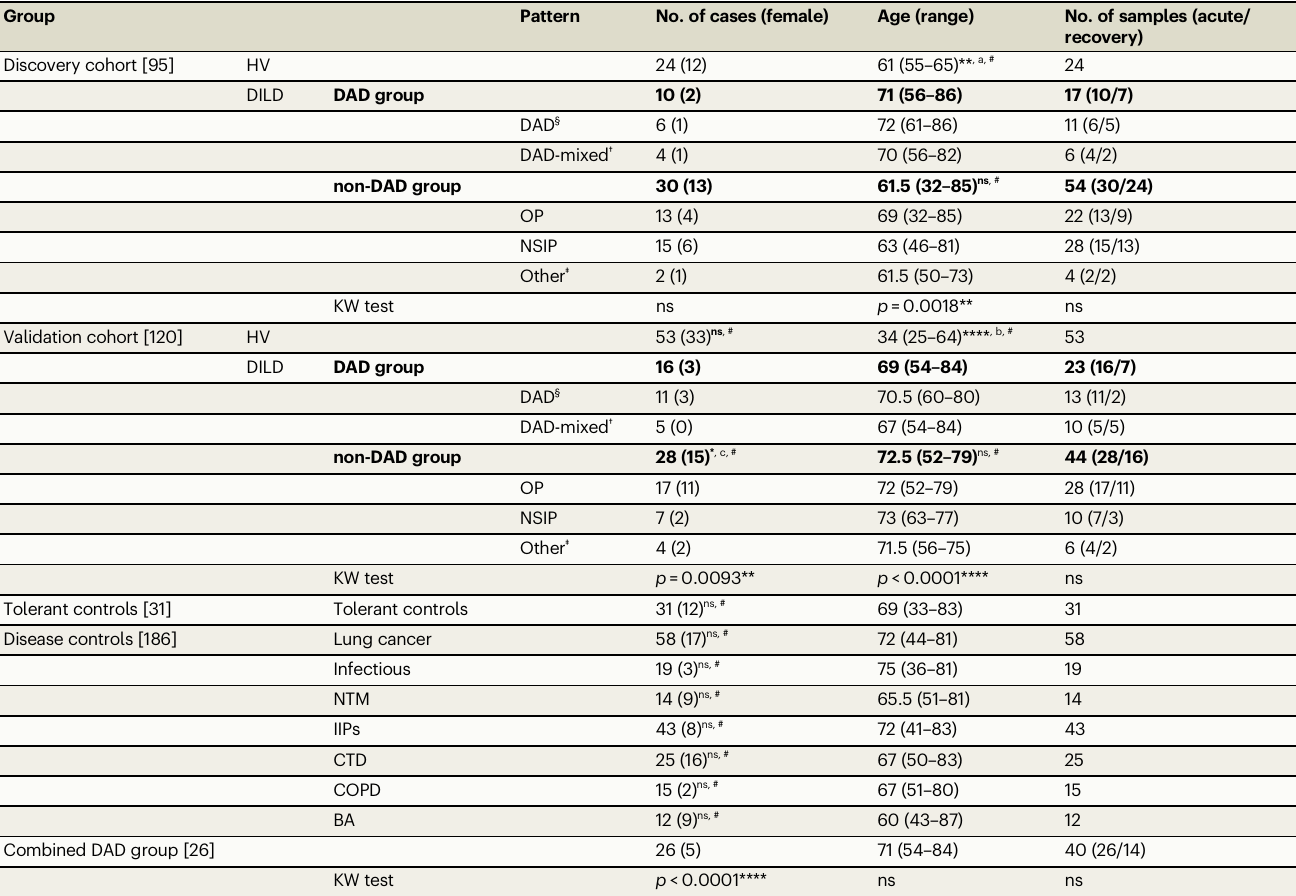
Table 1 | Sample cohorts used in this study: numbers and characteristics Group